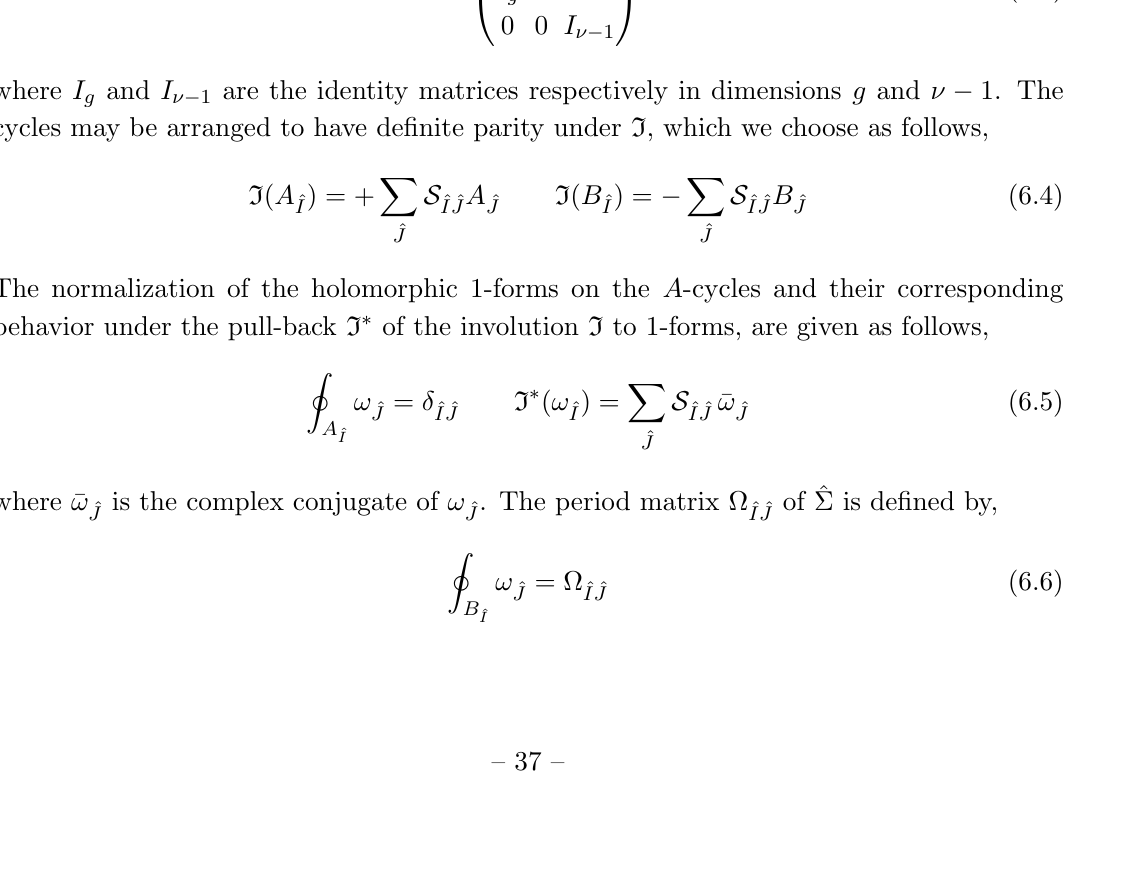
which is homologically trivial on g + (cid:23)